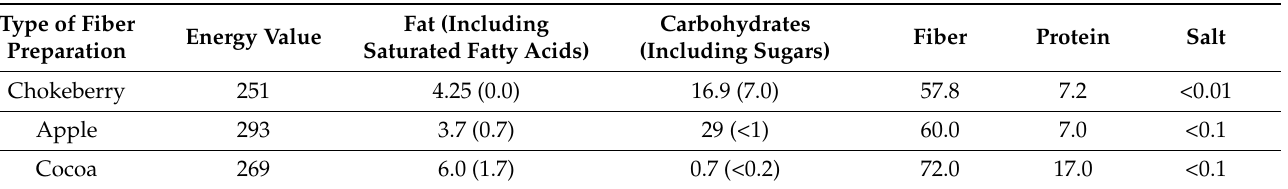
Table 1. Energy value (kcal/100 g) and nutrient and salt content (g/100 g) of the tested fiber preparations (according to the